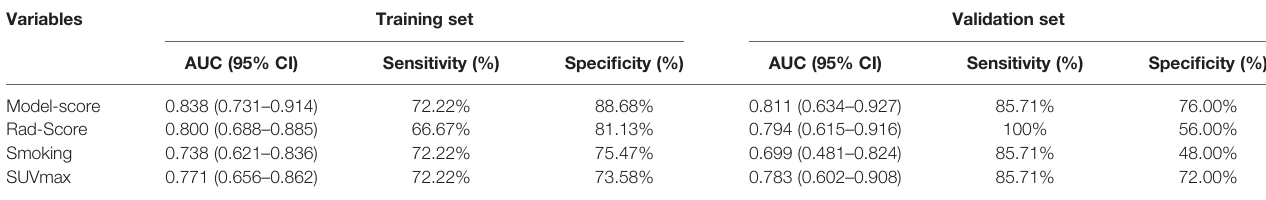
TABLE 3 | Predictive performance of variables in the training and validation sets.